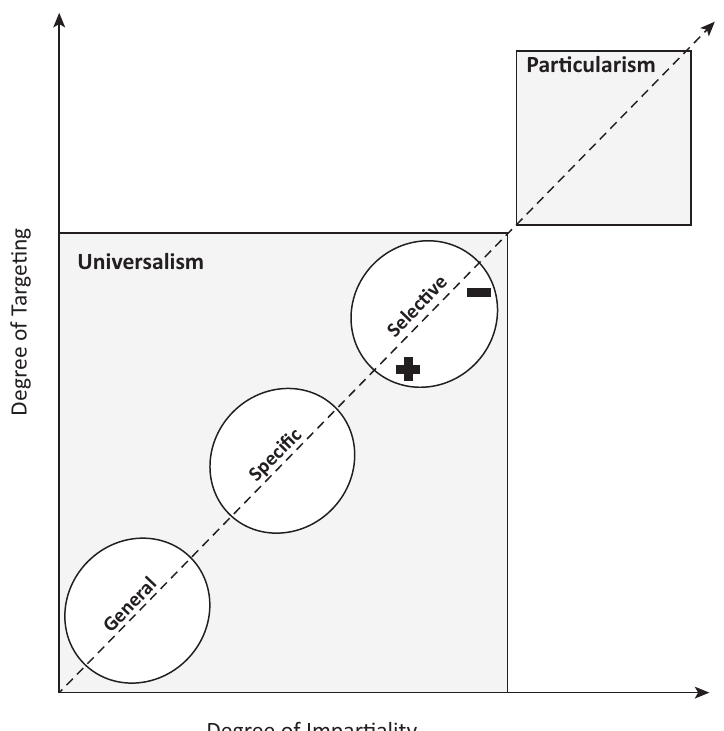
Figure 2. Universal benefit distribution based on degrees of impartiality and targeting. Adapted from Carey and Crammond